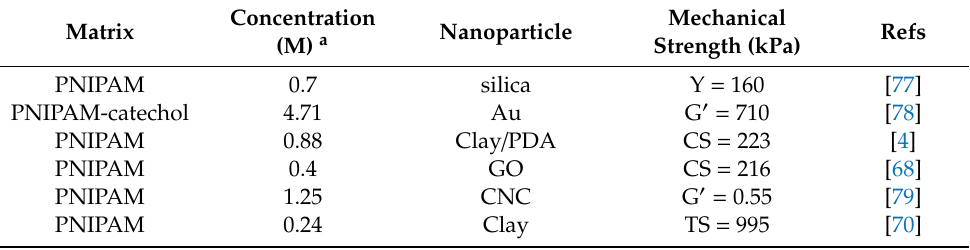
Table 2. Mechanical properties of the PNIPAM-based nanocomposite hydrogels. Mechanical Concentration Refs Nanoparticle Matrix Strength (kPa) (M) a PNIPAM 0.7 silica Y = 160 [77] PNIPAM-catechol 4.71 Au G (cid:48) = 710 [78] PNIPAM 0.88 Clay /